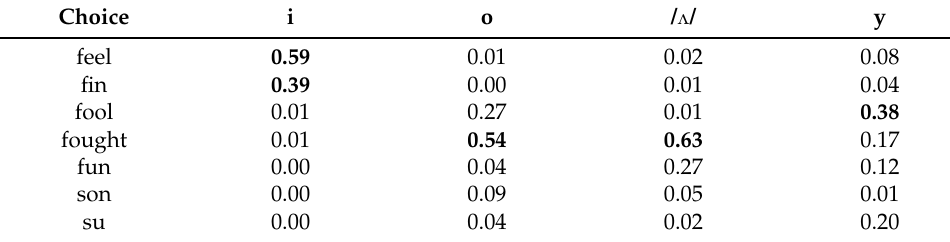
Figure 9. Percentage of each word choice given a phoneme in French and German in the L1 Spanish- English L2 group. Table 15. The percentage of categorizations of German phonemes in the L1 Spanish